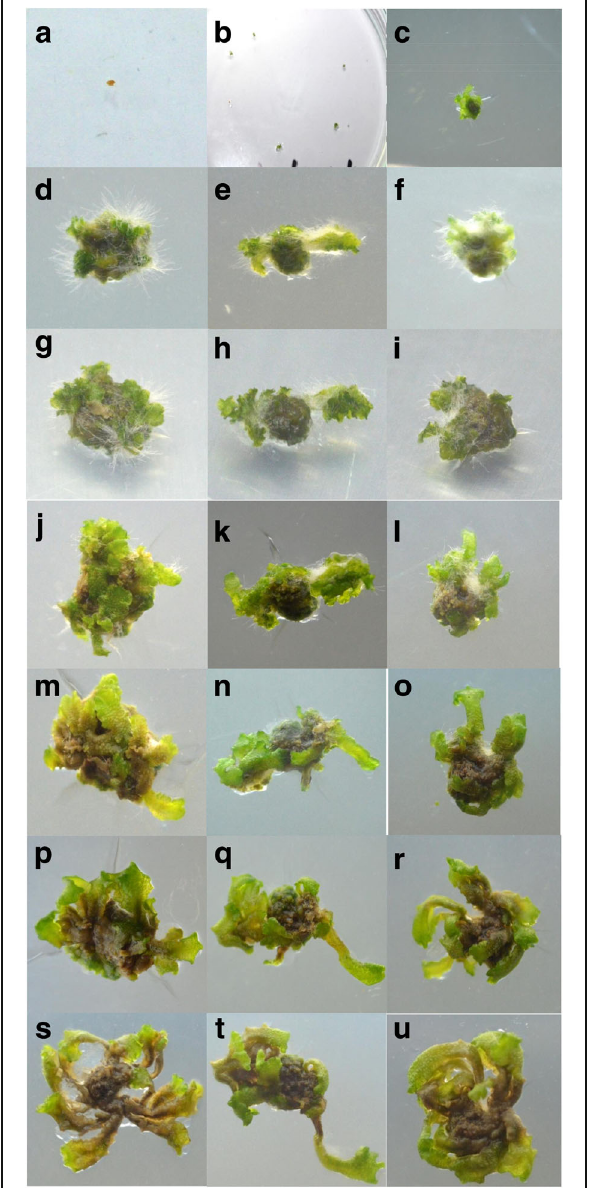
Fig. 1 In vitro growth of L. cruciata . a . gemmae placed on MS media b-c. Germinating gemmae after 16 – 17 days d-f. Thallus and rhizoids developed from gemmae g-i. Well developed thalli after repeated sub culturing j-l. Control of excessive growth of rhizoids by alternating hormone ratio and growth of dichotomously branched thalli. m-u Growth and maturation of thalli